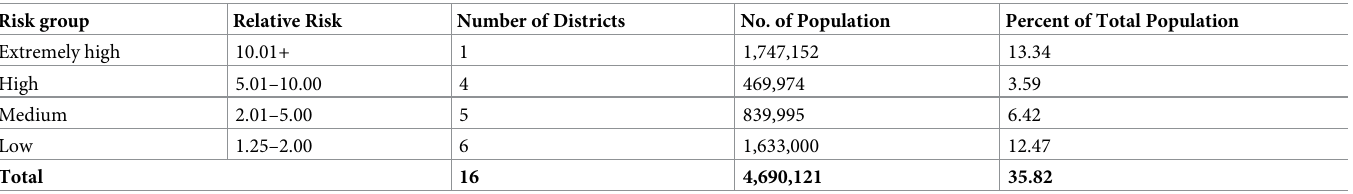
Table 1. Number of districts and population by risk group in